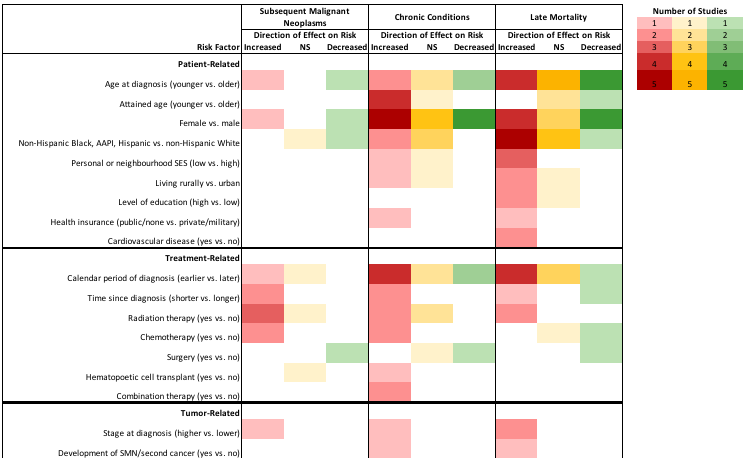
Figure 3. Descriptive representation of the direction of effect for patient-, tumor-, or treatment-related factors described in three or more studies on the risk for subsequent malignant neoplasms, chronic conditions and hospitalizations, and late mortality among AYA cancer survivors in cohorts with combined cancer types. Deeper colors represent more studies (n = 5) and white cells represent that no study investigated that risk factor (n = 0). Reference categories appear in parentheses. Abbreviations: AAPI, Asian-American and Pacific Islander; NS, non-significant; SES, socioeconomic status; SMN, subsequent malignant neoplasm.